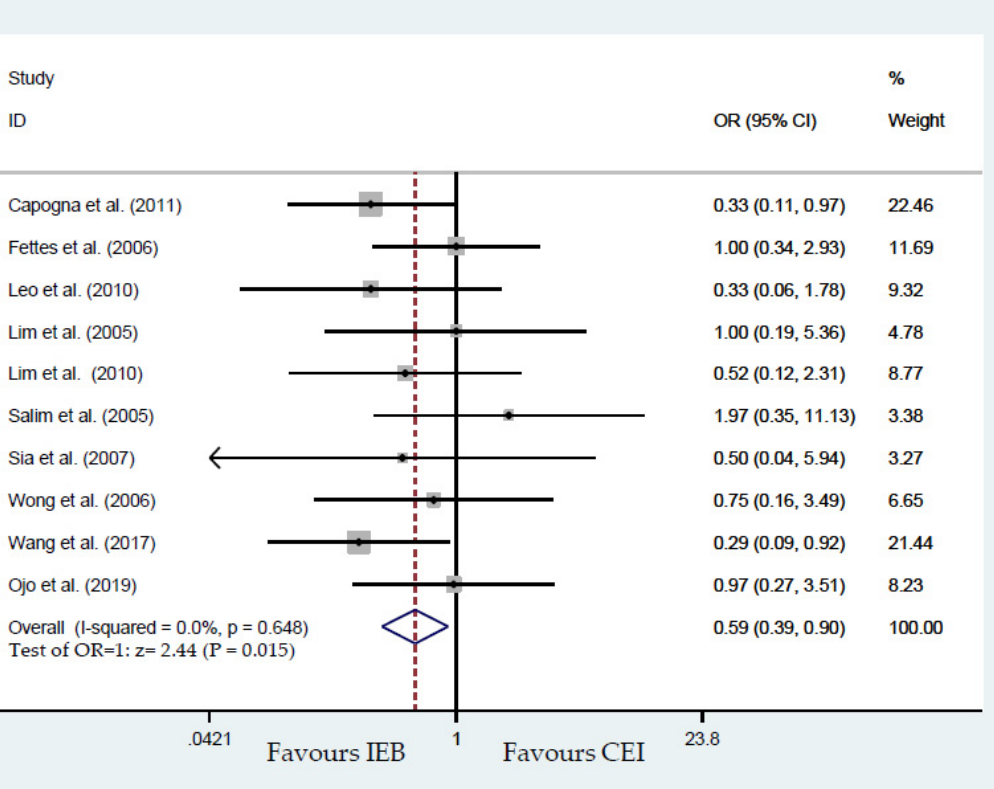
Figure 3. Overall effect for instrumental delivery mode.